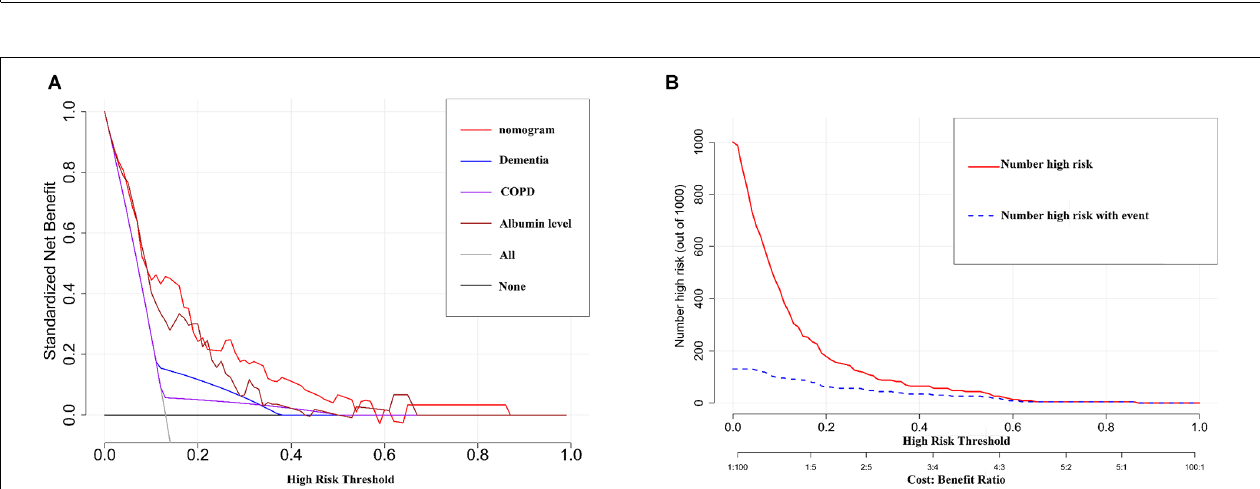
FIGURE 4 | The results of the DCA and the CIC analysis of the nomogram in the training set. (A) The DCA curve of the nomogram for predicting POD. It revealed that the nomogramcould obtain a greater net benefit than either the “treat all” or the “treat none” strategy and also get a higher net benefit than each predictor alone. (B) The CIC curve of the nomogram for predicting POD. The solid red line (Number high risk) represents the number of POD patients predicted using the nomogramat each threshold probability; the dotted blue line (number high risk with event) represents the number of true-positive POD patients at each threshold probability.